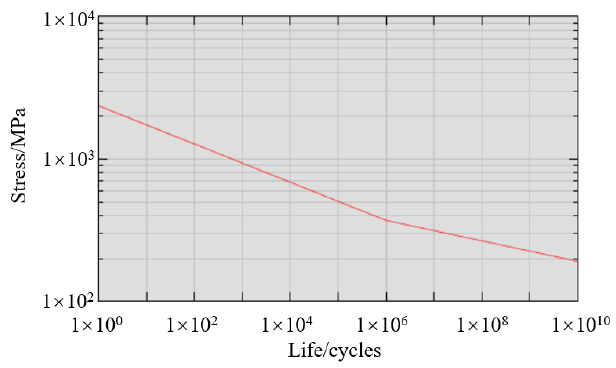
Figure 8. S-N curve of control arm material.